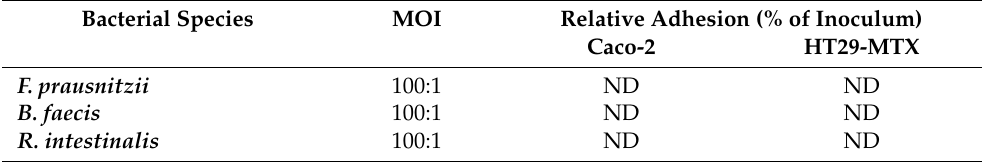
Table 1. Adhesion of F. prausnitzii , B. faecis and R. intestinalis to the di ff erentiated intestinal epithelial cells Caco-2 and HT29-MTX at di ff erent multiplicities of infection (MOIs). The percent adhesion